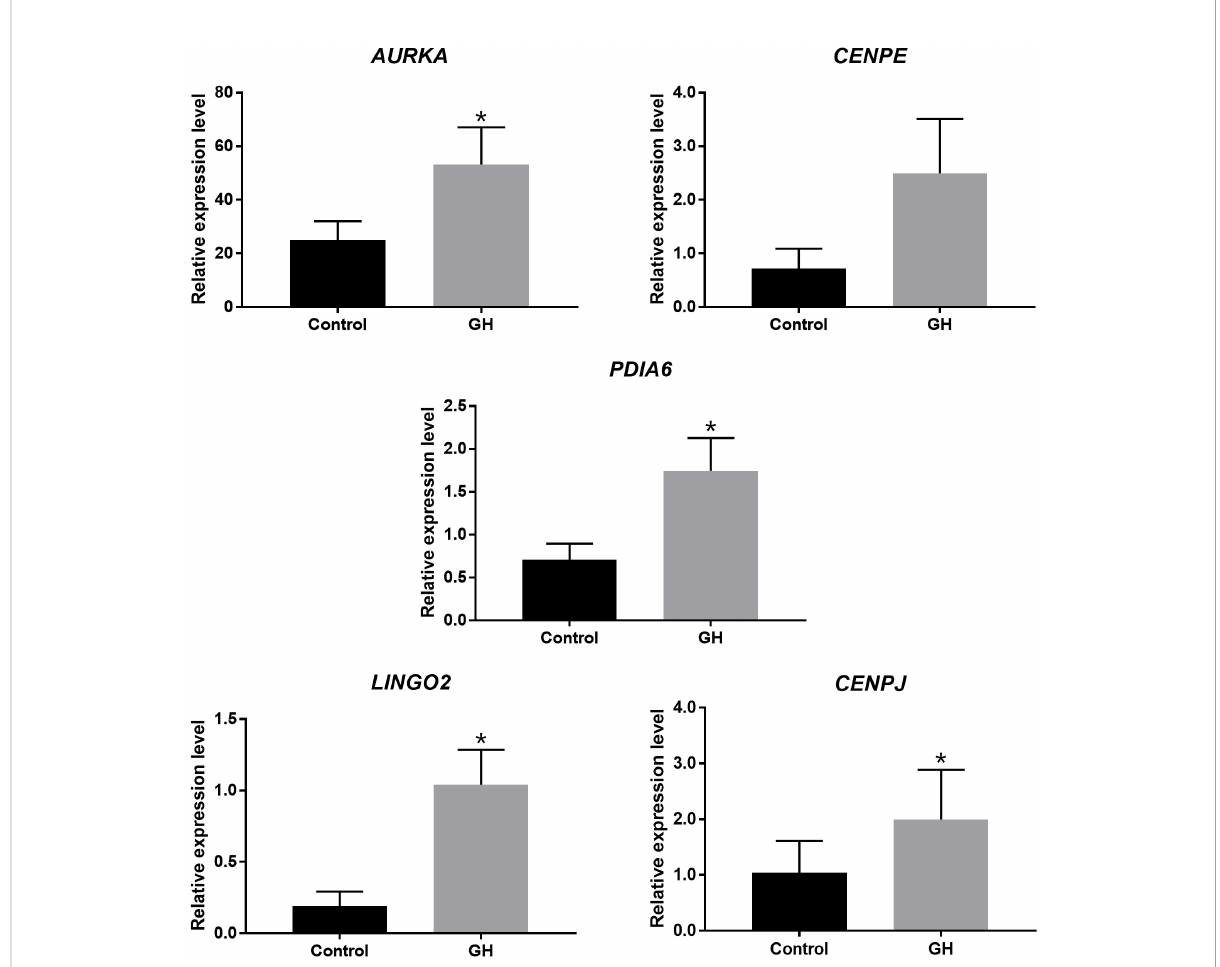
FIGURE 1 Expression of genes associated with meiotic progression and embryo development in human oocytes cultured with and without GH, assessed by Real-time PCR *P < 0.05 [From